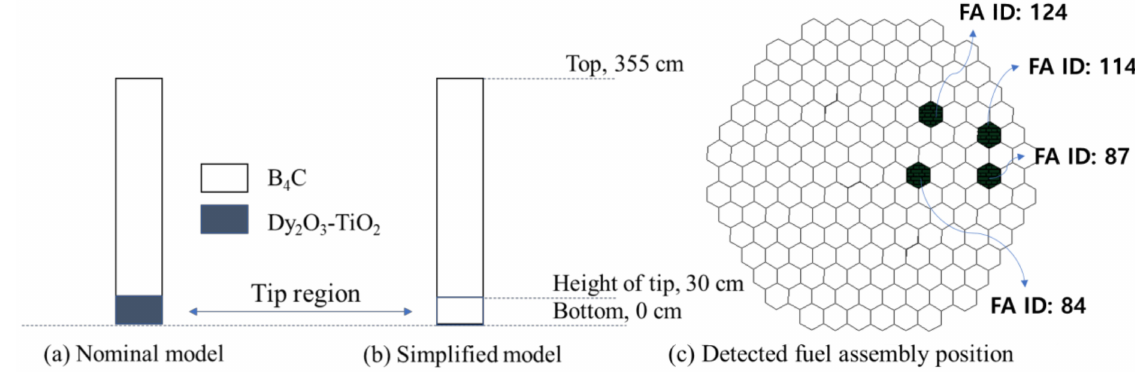
Figure 10. Axial composition of simplified control rod and measured fuel assembly